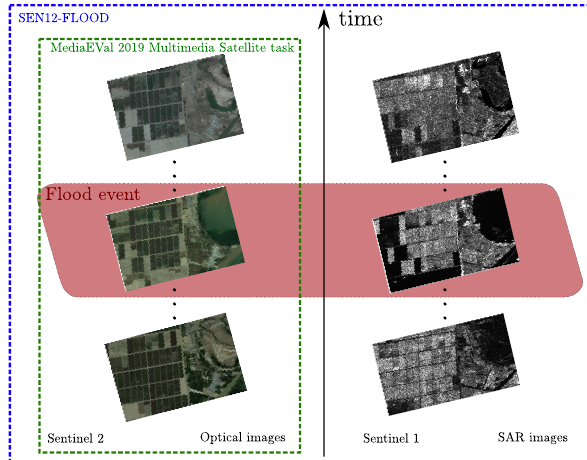
Figure 1. The SEN12-FLOOD dataset is composed of SAR and optical time series in which a flood event may